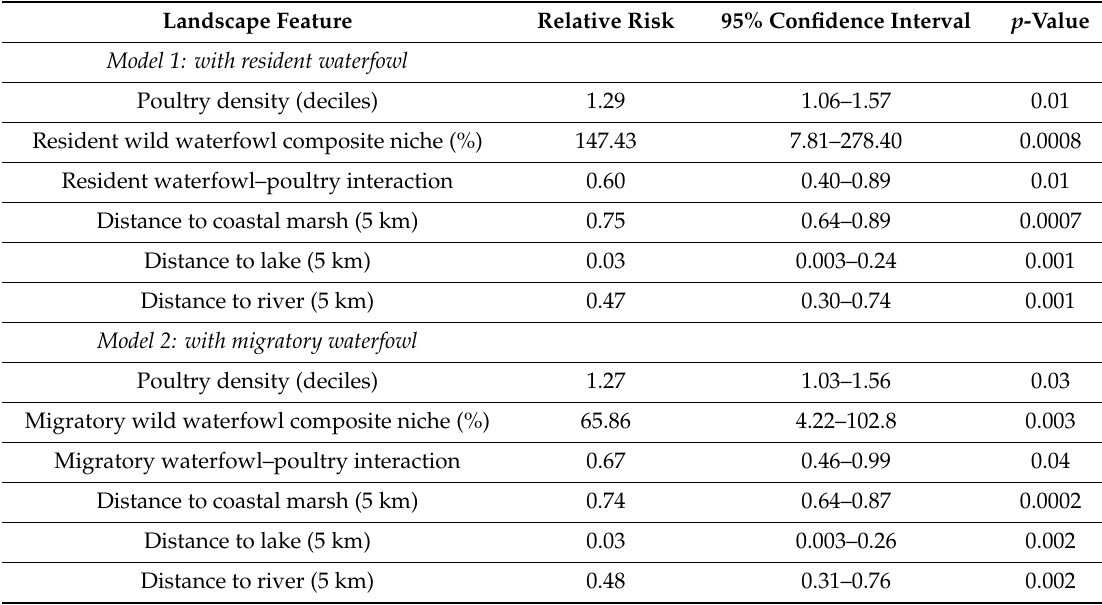
Table 1. Adjusted relative risks and 95% confidence intervals for the associations between highly pathogenic avian influenza virus, subtype H5N1, outbreaks and each landscape feature as derived from the best fitting inhomogeneous Poisson models for resident and migratory waterfowl, respectively. Each landscape feature is adjusted for all others in each of the two